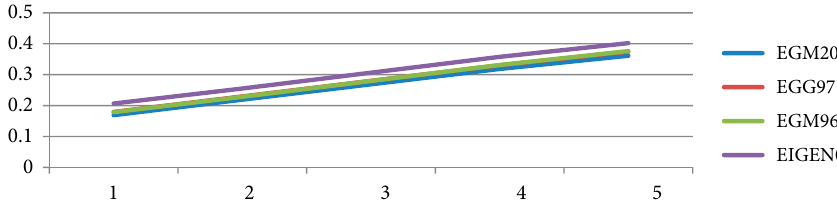
Fig. 13. Deviation of geoid heights N(m) from actual DEM a latitude